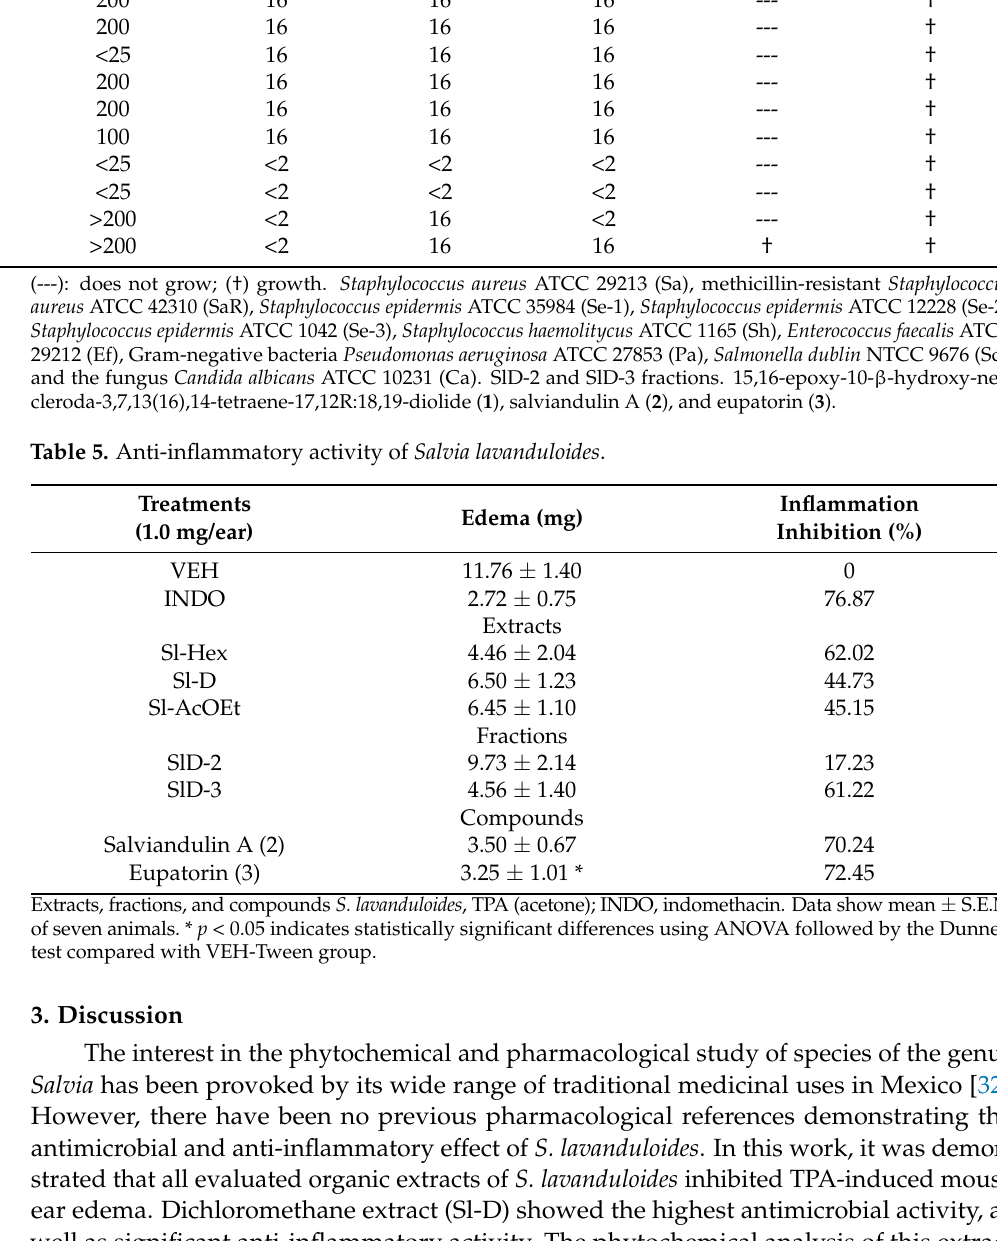
Table 4. Antimicrobial activity of Salvia lavanduloides fractions and compounds. Fractions µ g/mL µ g/mL Compounds Bacterium